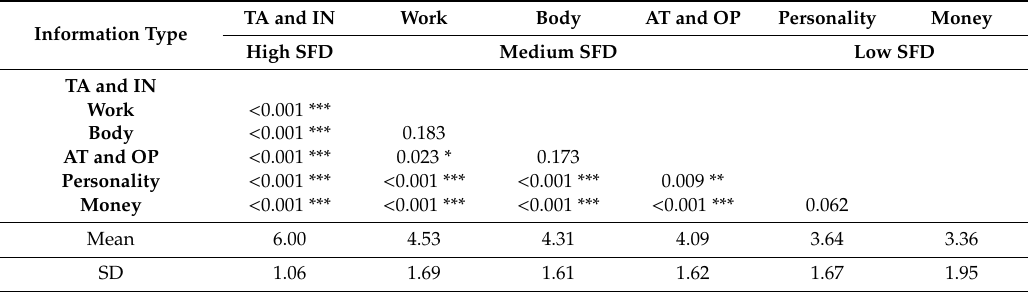
Table 2. Summary of post-hoc tests for self-disclosure in Experiment 1. SFD: self-disclosure, TA and IN: tastes and interests, AT and OP: attitudes and